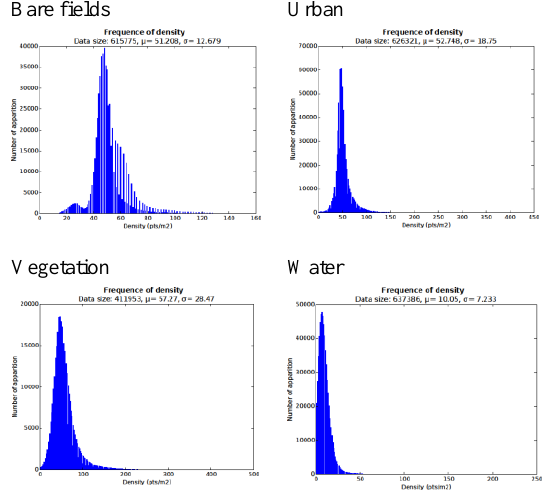
Figure 12. Histograms of point distribution by class (note, to aid interpretation, histograms are displayed with differing scales).